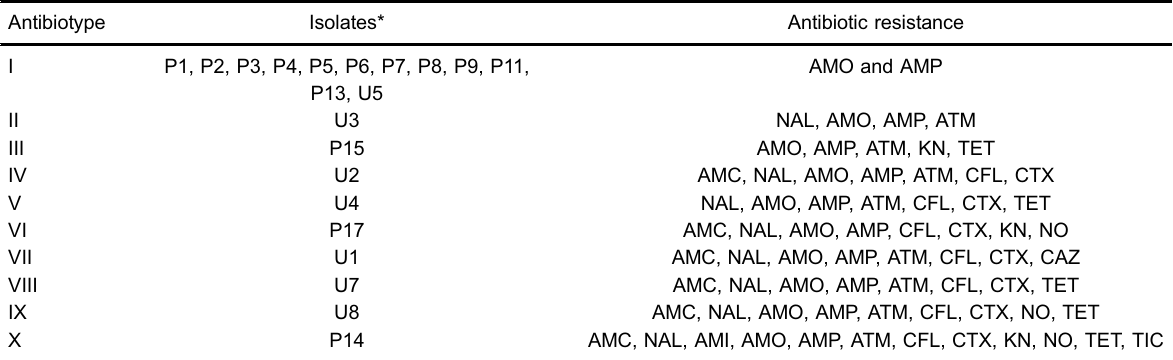
Table 3. Antibiotypes of Klebsiella isolates from modular enteral